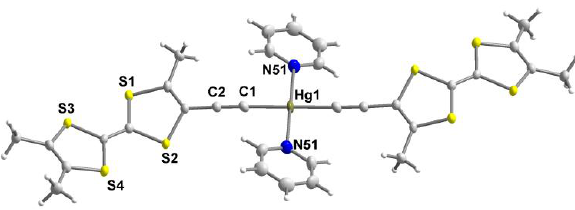
Figure 1. Molecular structure of trans -[Hg(C≡CMe 3 TTF) 2 (pyr) 2 ]. Ellipsoids are drawn at the 50% probability level. Table 1. Selected bond distances of the acetylide linker in (Å) and C≡C stretching IR frequency ( ν C≡C ) in the metal bis(acetylide) complexes (Hg, Pt, Ru) together with TTFs 1 and 3 .